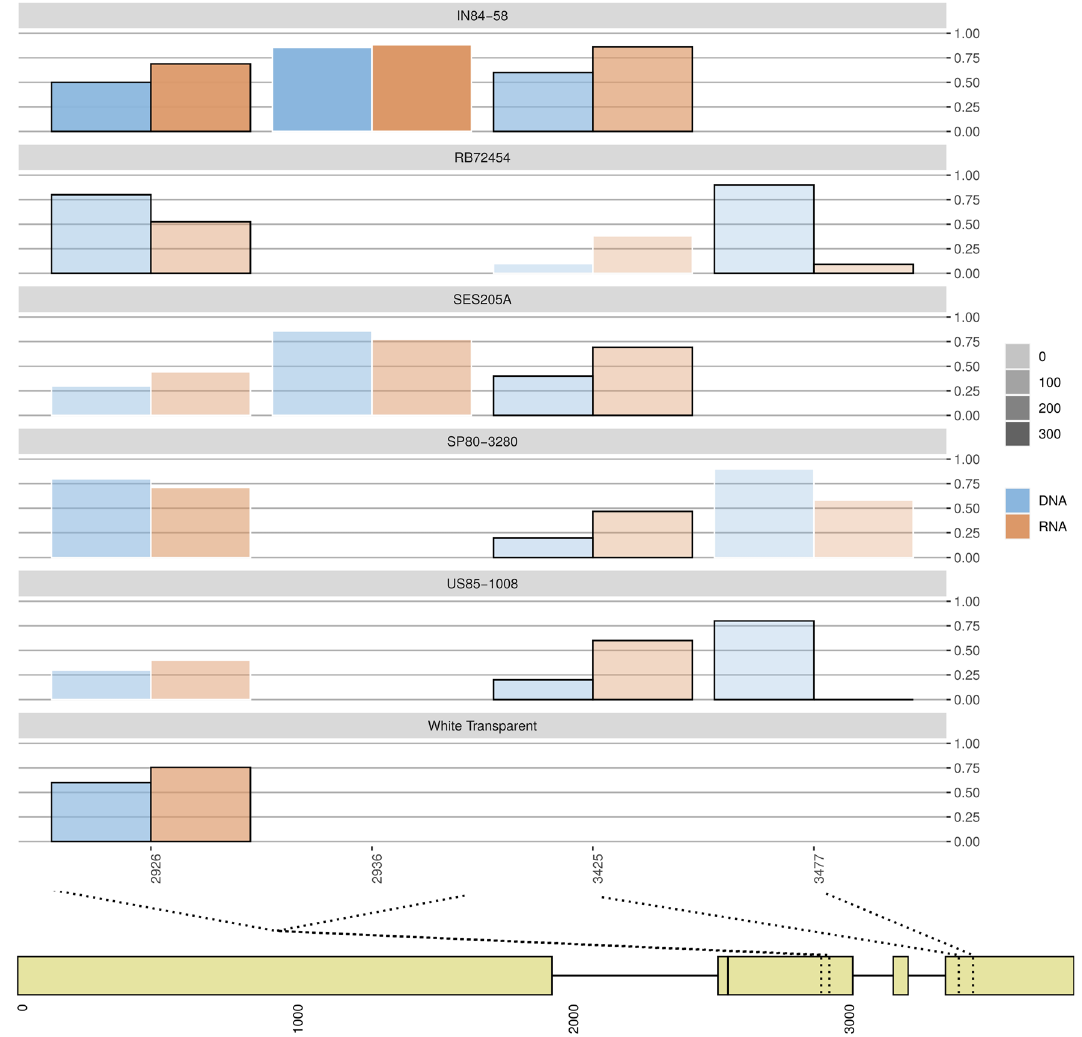
Figure 2. Relative genomic dose and relative expression of the reference allele from SNPs identified in the gene coding for enhanced disease resistance 2 . Relative genomic dose of the allele is represented by a blue bar. The expressed proportion of each allele is represented by orange bars. SNPs showing significant ASE have black borders, while those not showing ASE have white borders. The color gradient represents the average expression level of the allele. The bottom part of the plot has a schematic view of the gene showing the position of the